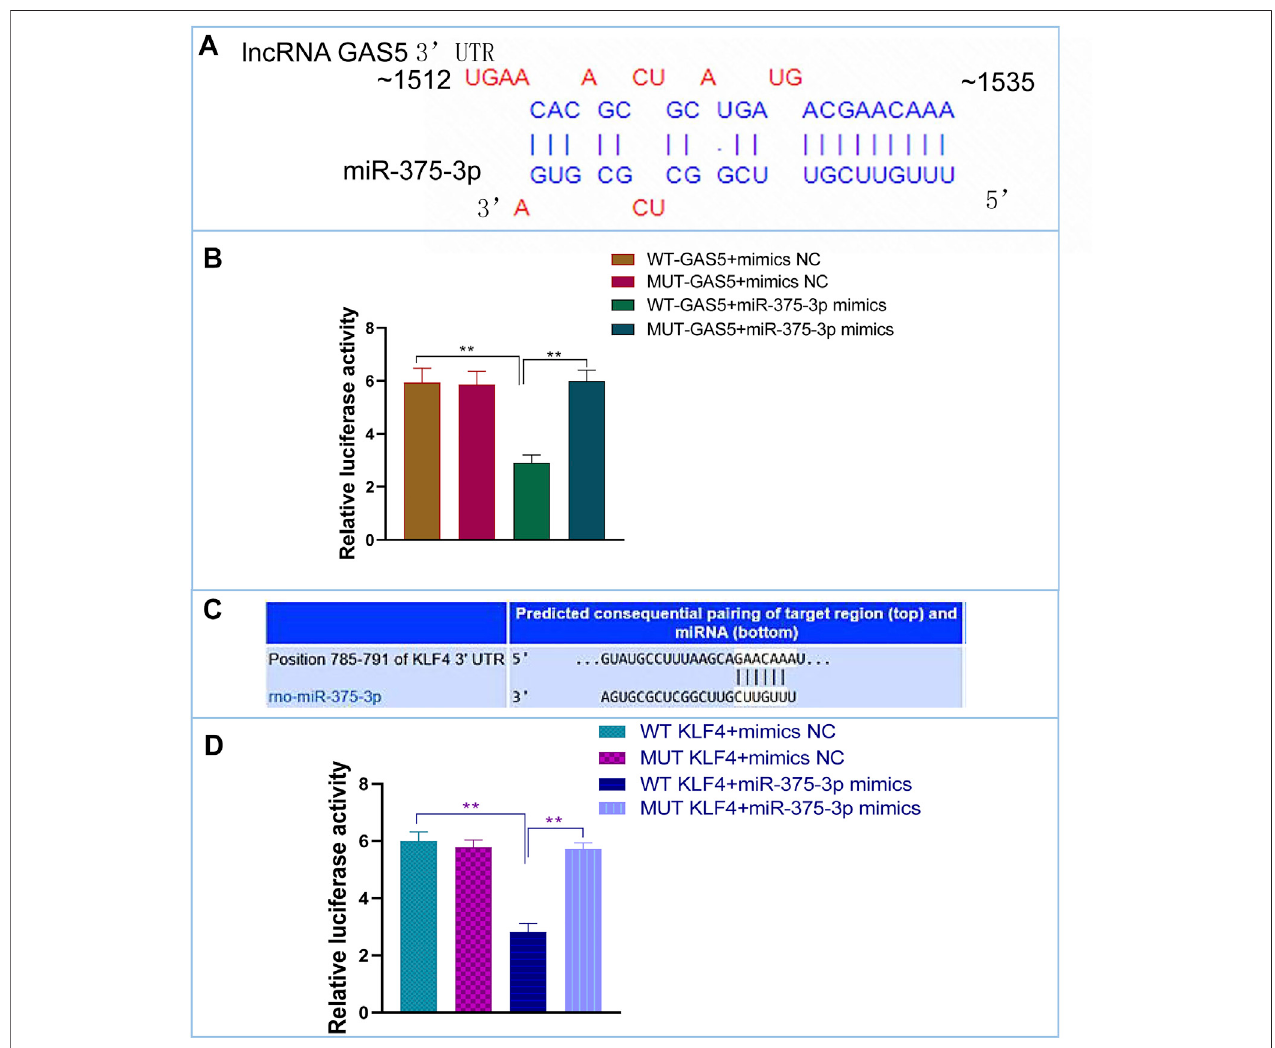
FIGURE 6 | The interactions of miR-375-3p with lncRNA GAS5 and KLF4. (A,C) Predicted duplex formation between lncRNA GAS5 and miR-375-3p (A) , and KLF4 3 ′ -UTR and miR-375-3p (C) . (B) The WT (MUT) GAS5 vector and miR-375-3p mimics or mimics NC were co-transfected into 293T cells. Dual luciferase gene reporter assay was performed to indicate that miR-375-3p could directly bind with the WT GAS5. (D) The WT (MUT) KLF4 3 ′ -UTR vector and miR-375-3p mimics or mimics NC were co-transfected into 293T cells. Dual luciferase gene reporter assay was performed to indicate that miR-375-3p could directly bind with the WT KLF4. All the experiments were repeated three times. ** p < 0.01. WT, wild-type; MUT, mutant type; NC, negative control.